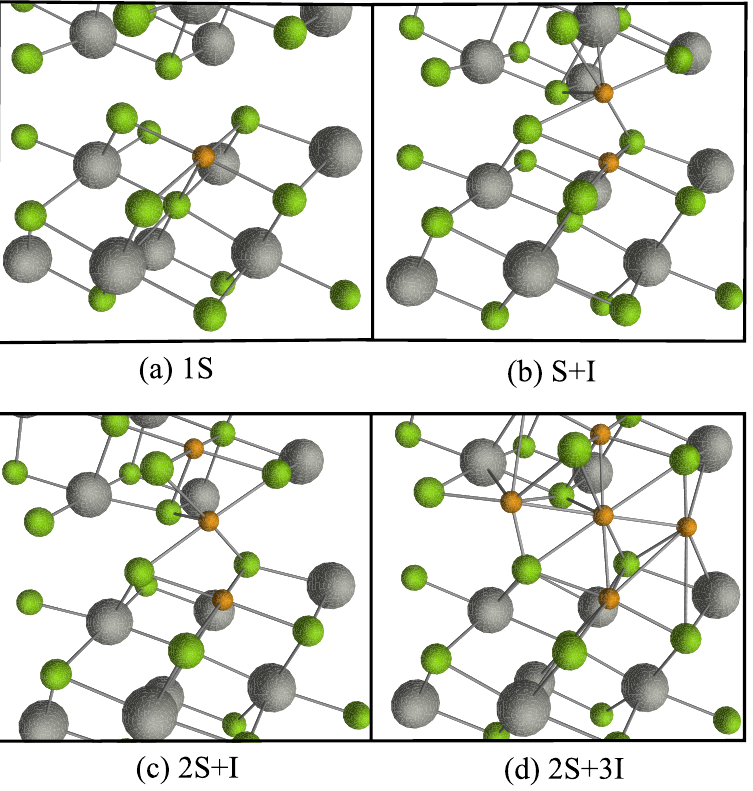
Figure 2. The four defect structures for which formation energies were calculated for in the Bi 2 Te 3 crystal lattice. ( a ) 1 S − a substitutional transition metal dopant residing in a Bi crystal site. ( b ) S + I − substitutial and interstitial atoms location adjacent to one another. ( c ) 2 S + I − further clustering of metallic atoms. ( d ) 2 S + 3 I − this defect corresponds to large amount of metallic atoms clustering together, observed as the formation of metallic bonds. Bismuth atoms are displayed in grey, tellurium in green, and transition metal dopants in